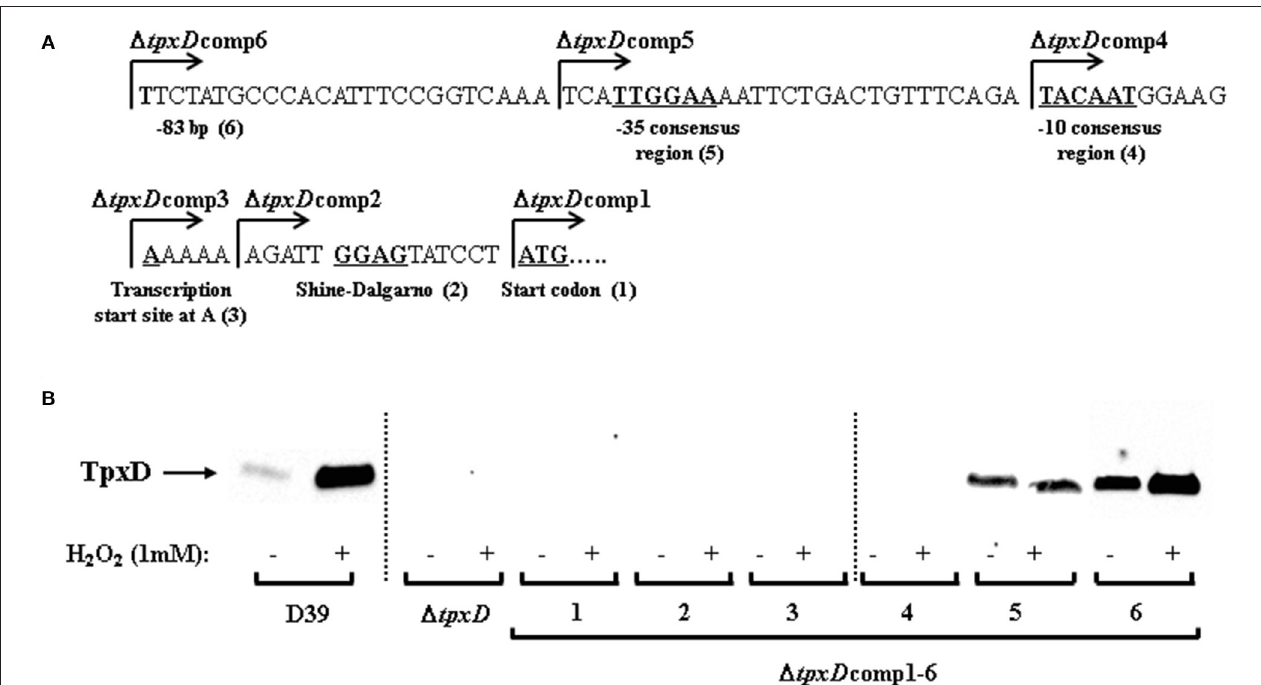
FIGURE 2 | Identification of tpxD regulatory promoter elements. (A) In silico analysis of tpxD proximal promoter region. Identification of tpxD promoter elements using BPROM algorithm: ATG start codon (1); Shine Dalgarno (2); transcription start site at A (3); − 10 and − 35 elements of the σ 70 promoter (4 and 5, respectively). The first nucleotide included in each of the 1 tpxD comp mutants (1–6) is indicated by arrow. (B) Influence of tpxD putative regulatory elements on TpxD expression levels under H 2 O 2 stress. TpxD levels, determined by Western blotting, were measured in D39, 1 tpxD and 1 tpxD comp1-6 (described in Figure 2A ). Bacteria were grown anaerobically to OD 620 = 0.25 and then challenged with 1 mM H 2 O 2 for 40 min. Separated proteins were electroblotted onto 0.45 µ m nitrocellulose membrane, and stained with Ponceau S to ensure equal loading, before incubation with antibodies. Membranes were exposed for long time intervals to ensure the absence of bands in 1 tpxD comp1-4 and are lined up, as indicated in the figure. Densitometry was performed using ImageJ